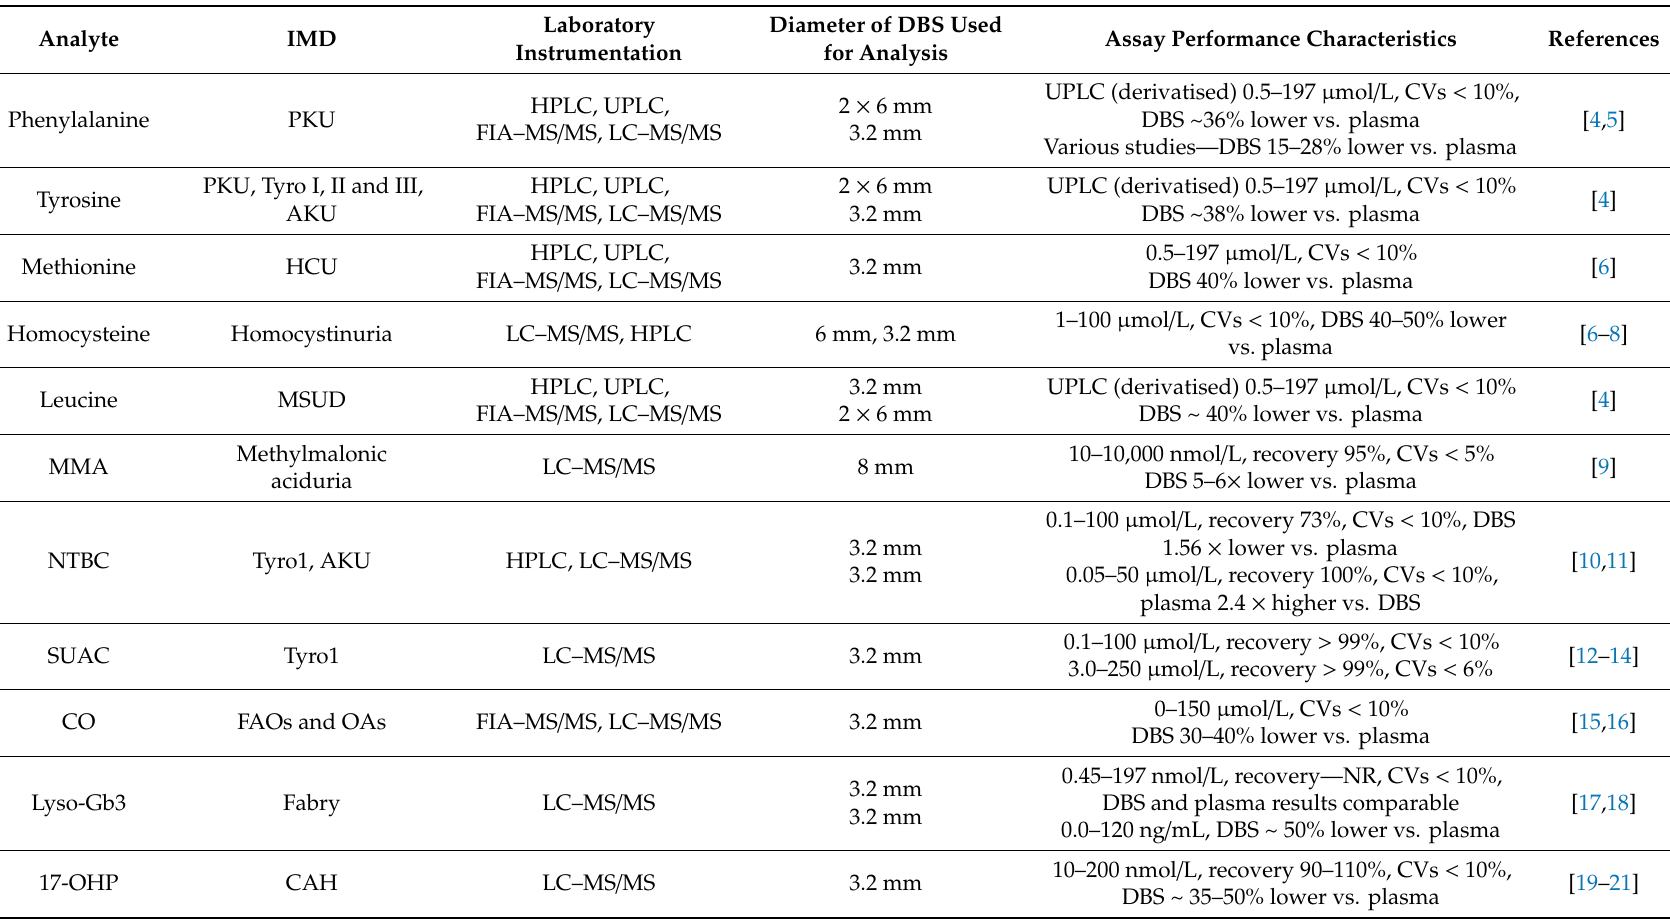
Table 1. List of analytes measured in dried blood spot (DBS) specimens for the monitoring of patients with various inherited metabolic disorders